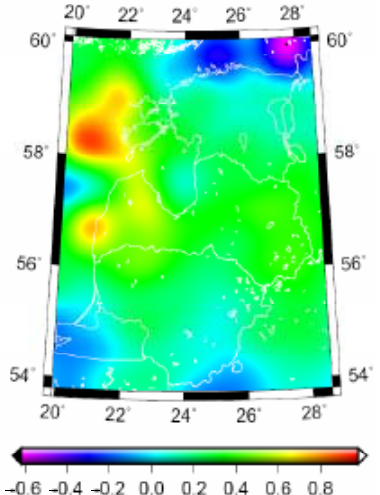
Fig. 3. Discrepancies between the whole spectra of the EIGEN-GL04c and EGM96 geoid models, ∆N 2;360 . The discrepancies range from –0.62 m to +0.91 m with a mean of +0.23 m. Generally, the EIGEN-GL04c geoid appears to be higher than that of the EGM96 model. Standard deviation of the detected discrepancies amounts to 0.23 m